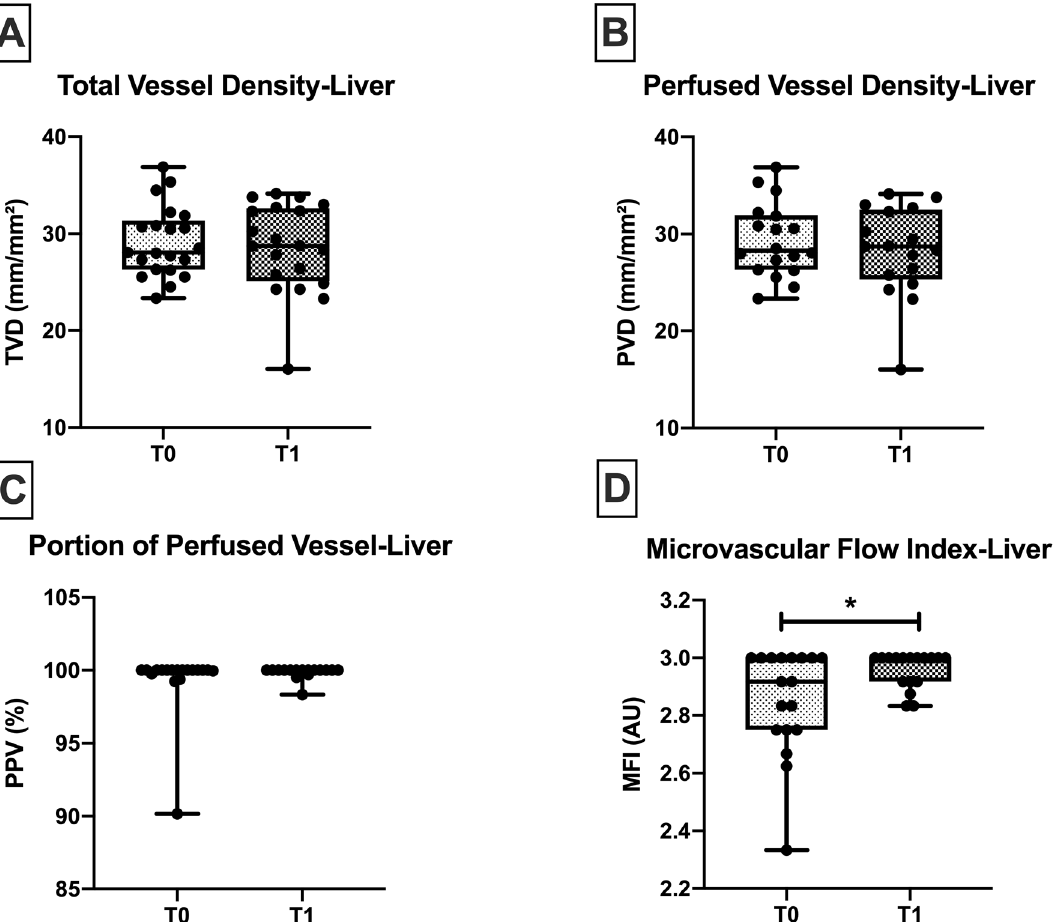
Figure 4. Liver microcirculation. Liver microcirculatory parameters at the beginning of surgery (T0) and end of surgery (T1). A significant increase was found in the hepatic MFI from T0 to T1 in 18 patients. TVD; total vessel density. PVD perfused vessel density, PPV portion of perfused vessel, MFI microvascular flow index. Values are represented as median [interquatile] for PVD and MFI and mean ± SD for TVD and PVD, * p <